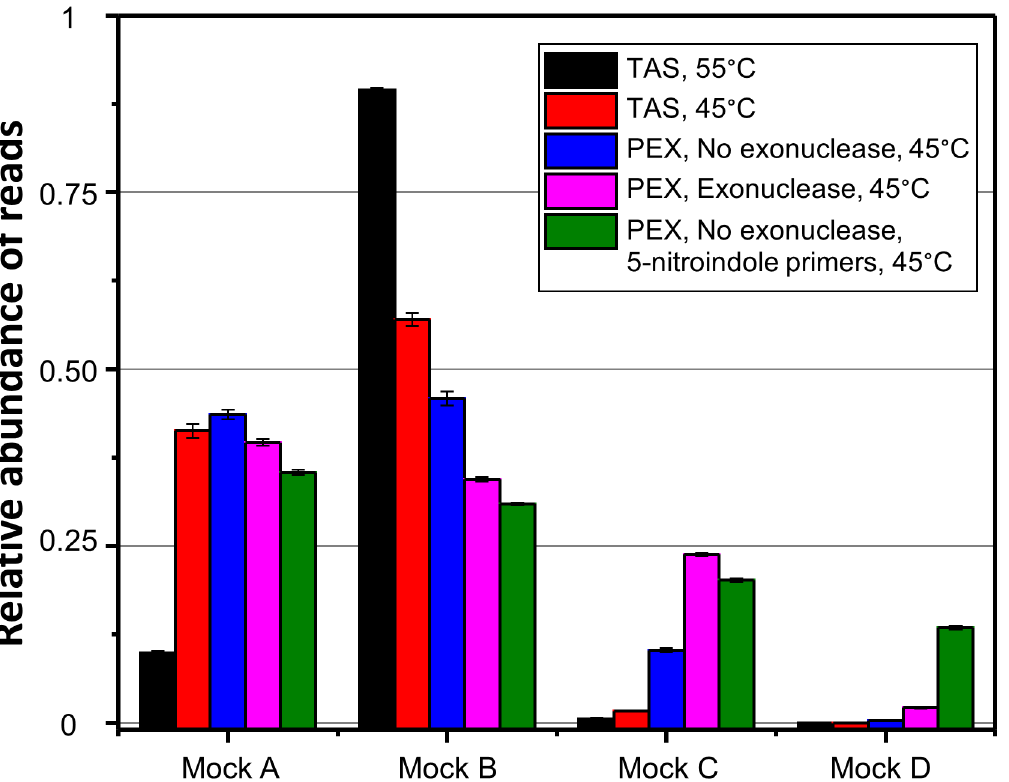
Fig 5. Relative abundance of mock DNA templates observed in sequencing of TAS and PEX PCR method reactions. The error bars represent standard deviation associated with two replicates per sample.